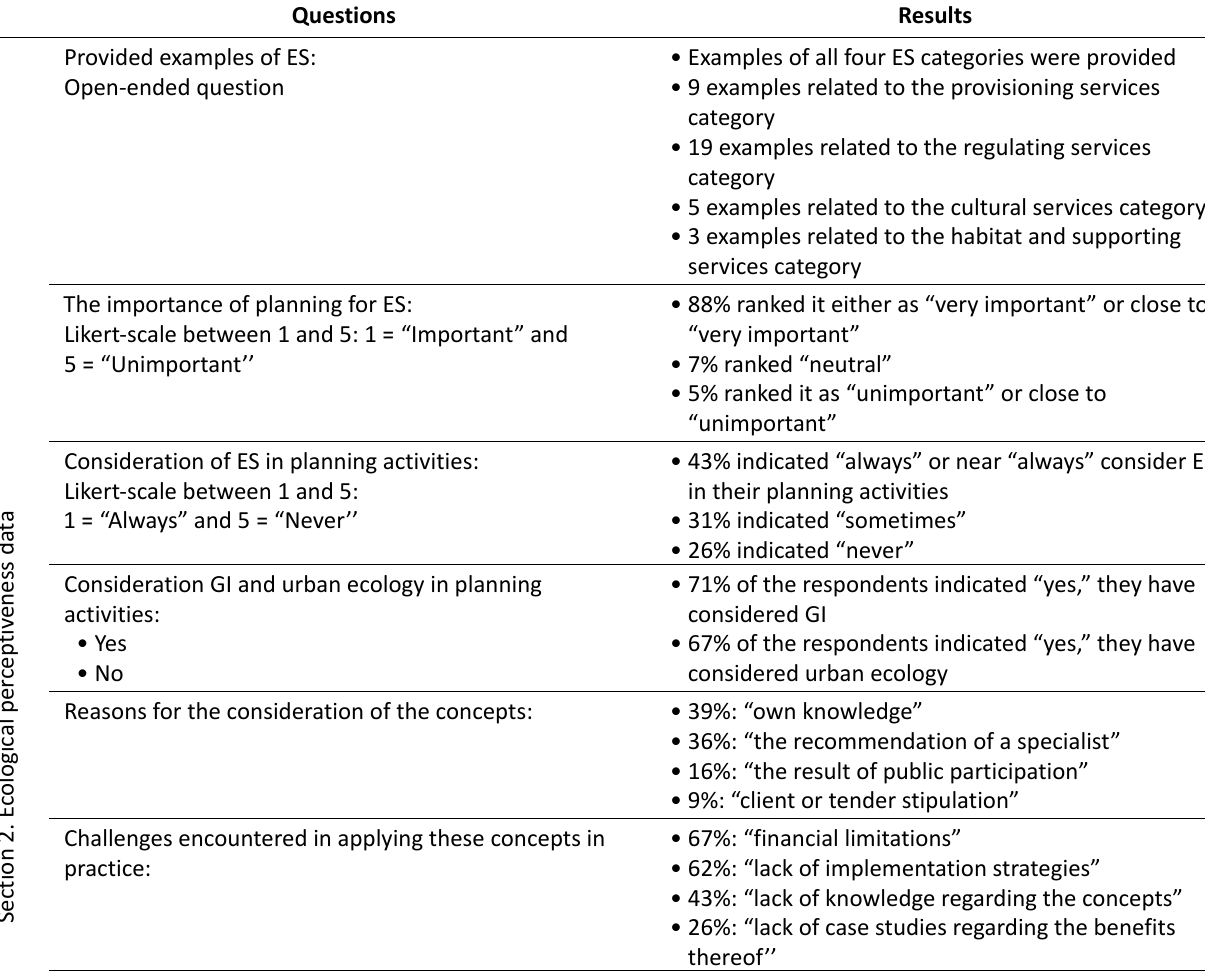
Table 1. (Cont.) Results of the online